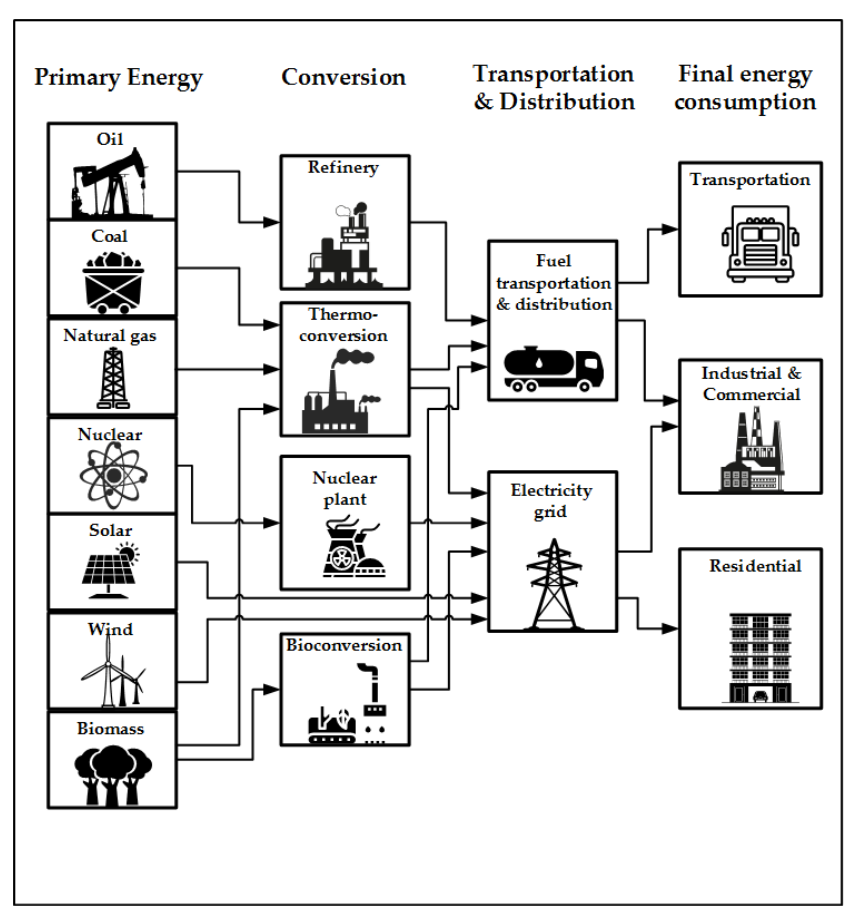
Figure 1. Energy system showing the flow of energy from primary energy supply to final energy consumption.